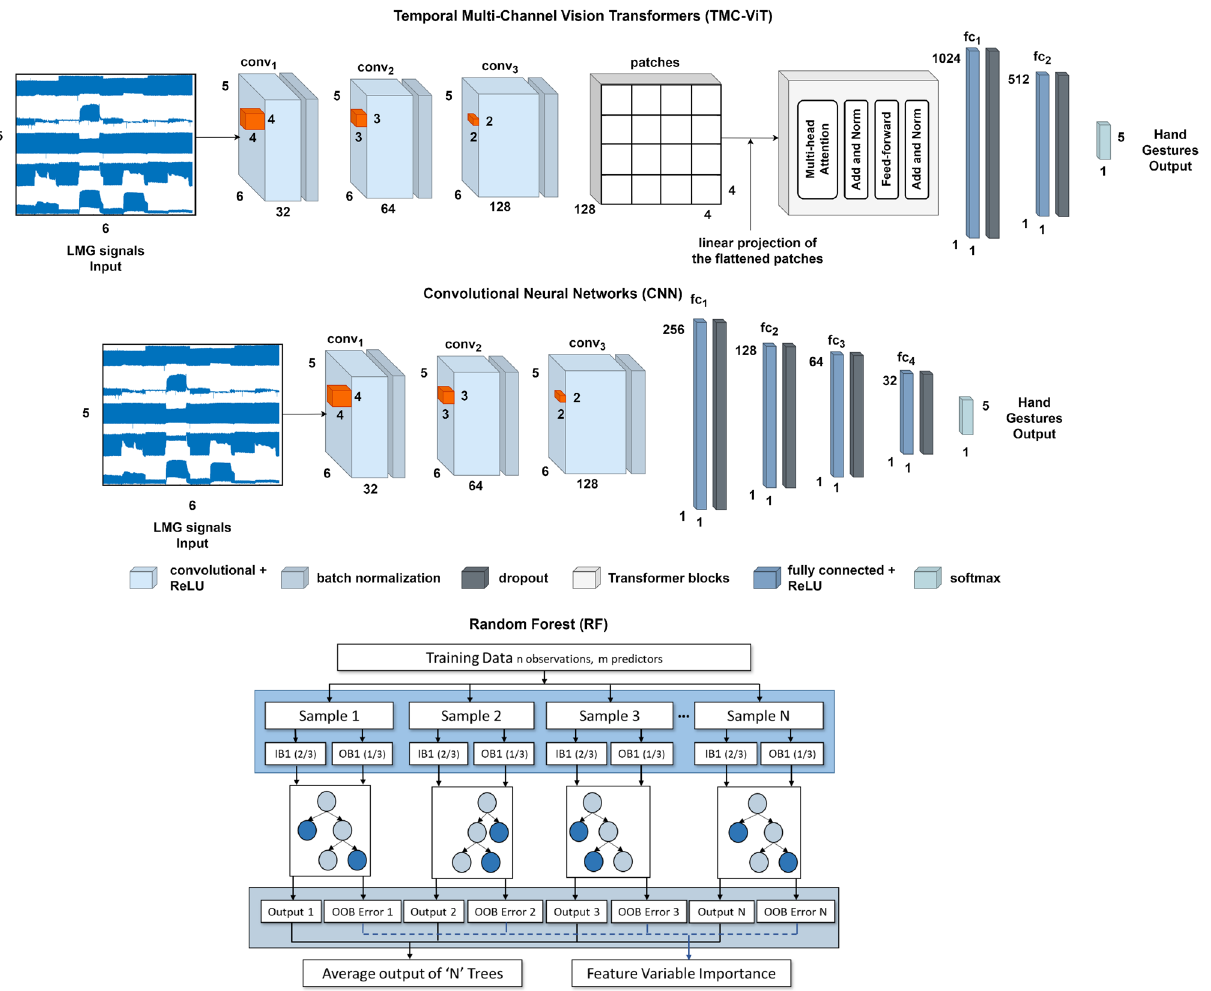
Figure 5. Temporal Multi-Channel Vision Transformers, Convolutional Neural Network, and Random Forest models developed to decode human hand